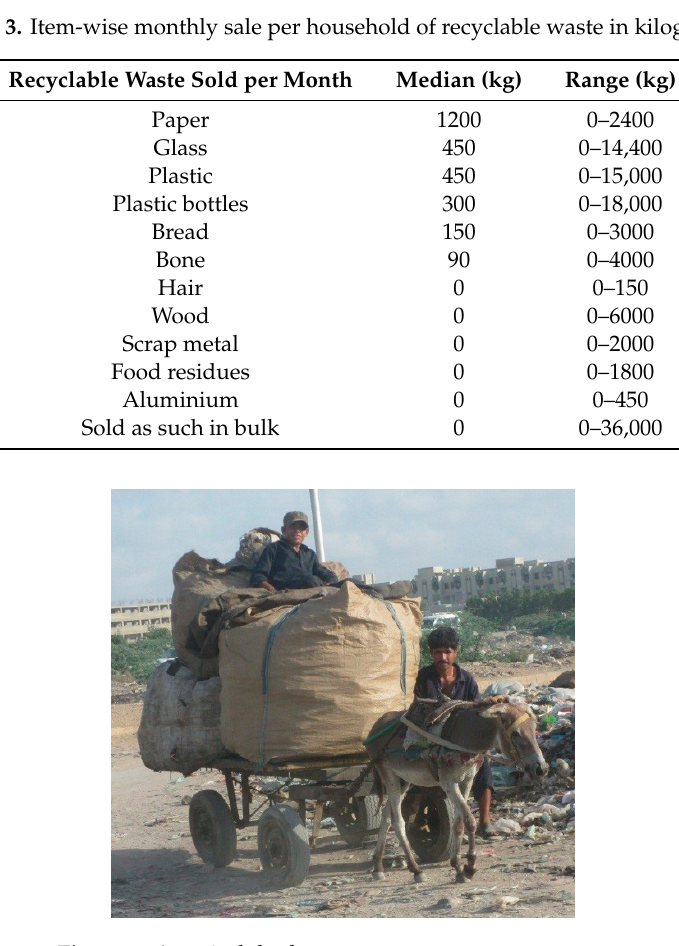
Figure 1. A typical donkey cart waste management team.